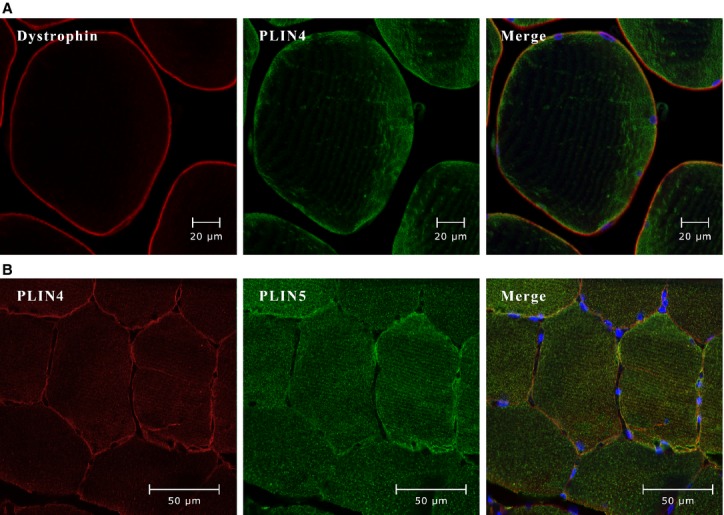
Perilipin (PLIN)4 is close to the sarcolemma of skeletal muscle fibers whereas PLIN5 is spread uniformly. (A) Representative images (630X) from confocal fluorescence microscopy of semithin (5 μm) cross sections of paraffin-embedded human m. vastus lateralis biopsy (n = 10). Dystrophin (red, rabbit anti-dystrophin) binds to the outside of the sarcolemma, whereas PLIN4 (green, guinea pig anti-PLIN4) is located at or just beneath the sarcolemma. (B) The image (400X) was obtained by confocal fluorescence microscopy of sections of paraffin-embedded biopsies from m. vastus lateralis (n = 10), stained with antibodies against PLIN4 (red, rabbit anti-PLIN4) and PLIN5 (green, guinea pig anti-PLIN5).